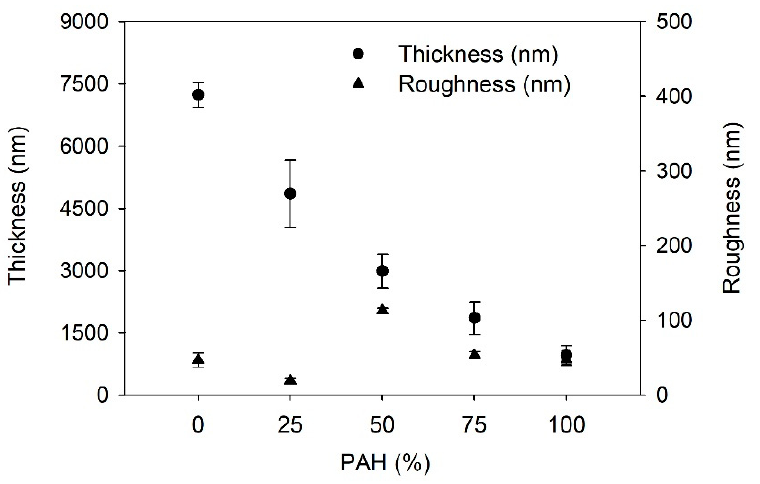
Figure 1. Thickness and roughness of as-prepared LbL film as a function of PAH ratio.